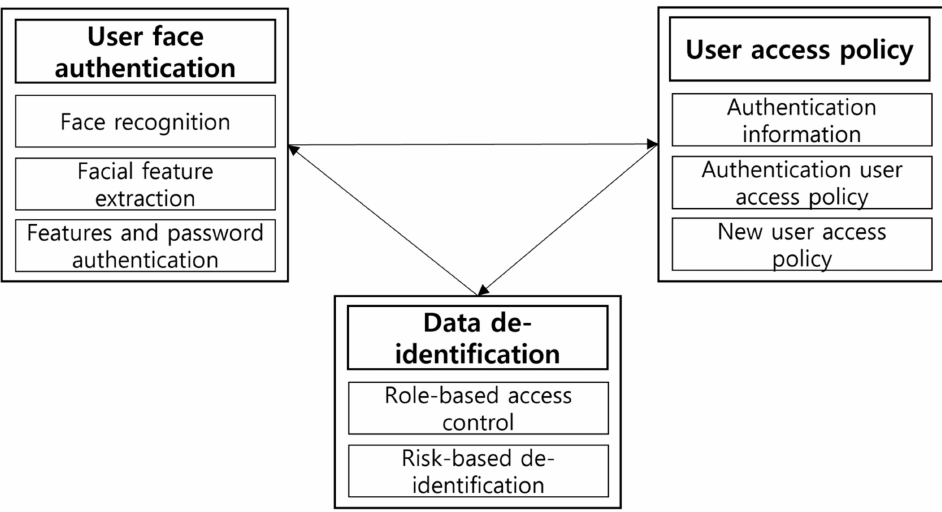
Figure 1. The de-identification mechanism model of the user data in the imaging